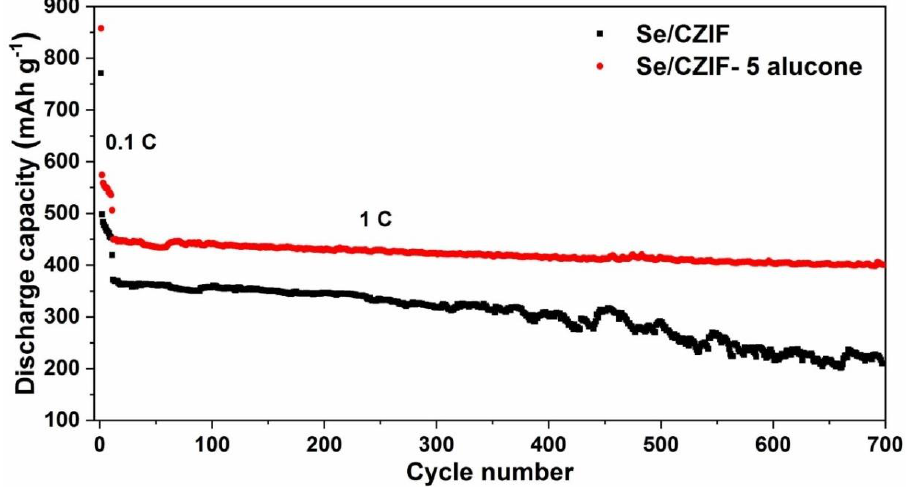
Figure 5. Long cycling performance of Se/CZIF and Se/CZIF − 5 alucone at a rate of 0.1 C during the first 10 cycles and 1 C for the subsequent cycles.